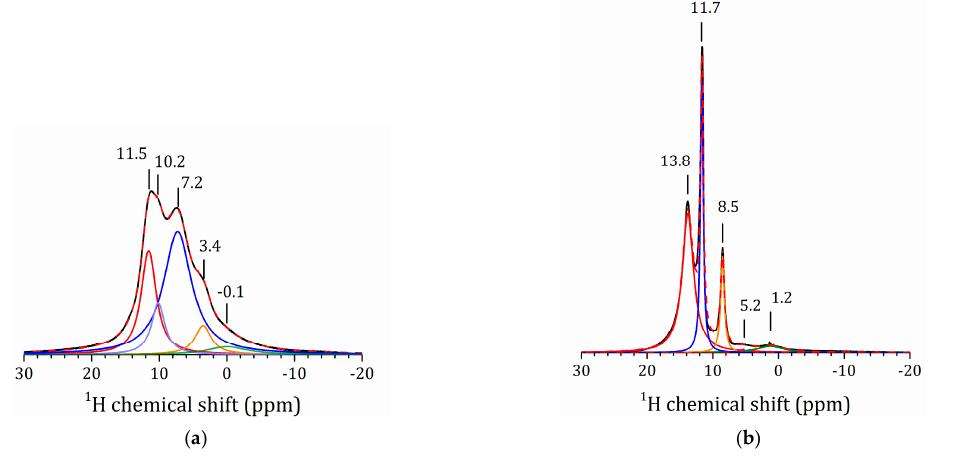
Figure 6. 1 H MAS NMR spectra of HLT 3 × MeOH ( a ) and HLT 3 ( b ) and their decomposition. Dashed lines show the total fit.